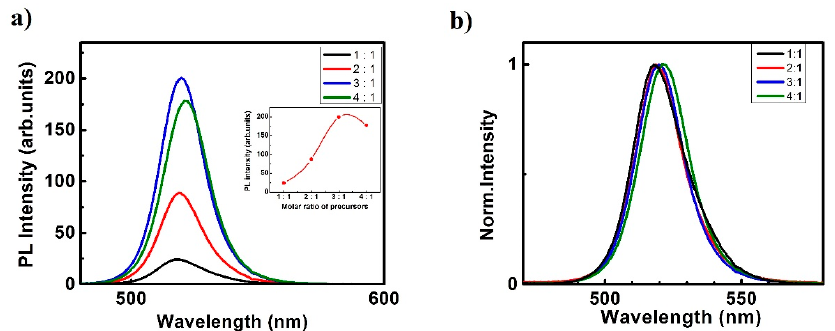
Figure 7. ( a ) Photoluminescence (PL) spectrum for di ff erent molar ratio of precursors. Excitation wavelength was 458 nm. The inset shows the peak intensity as a function of precursor